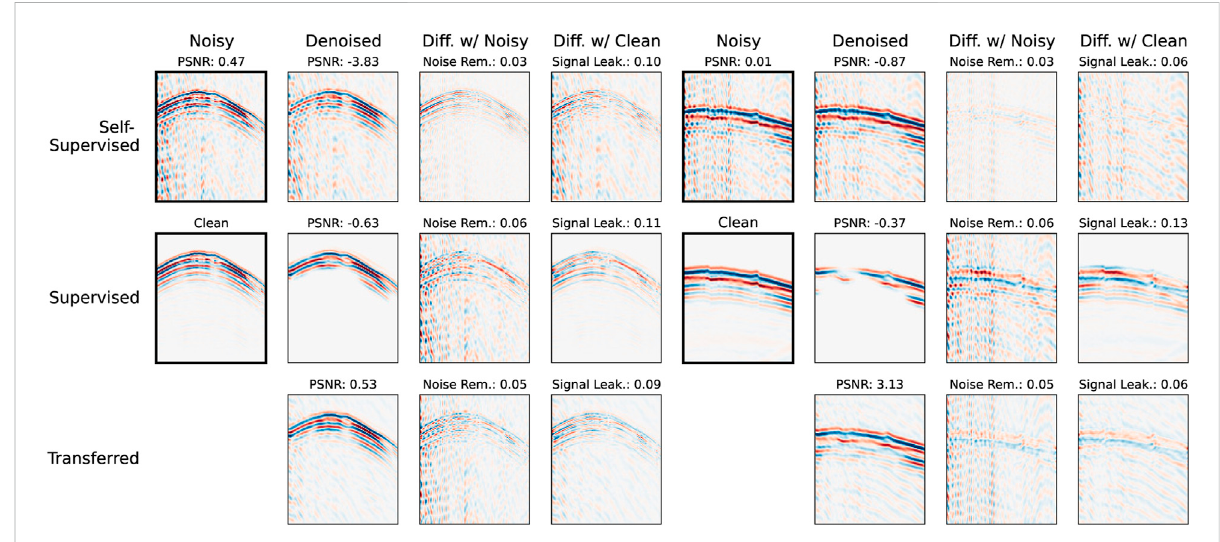
FIGURE 6 Two semi-synthetic events denoised by the three different networks: self-supervised (top row), supervised (middle row) and the transfer learning network (bottom row). The fi rst and fi fth columns illustrate the noisy and clean data, while the second and sixth display the denoised products. The next two columns show the difference between the noisy and clean data, respectively, for the denoising products of the different networks. Values for the PSNR, noise removed and signal leakage are given in each subplots